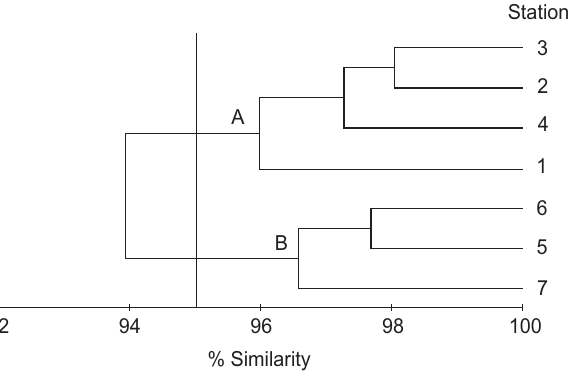
Figure 7. Cluster Analysis of the total copepod density between the sampling